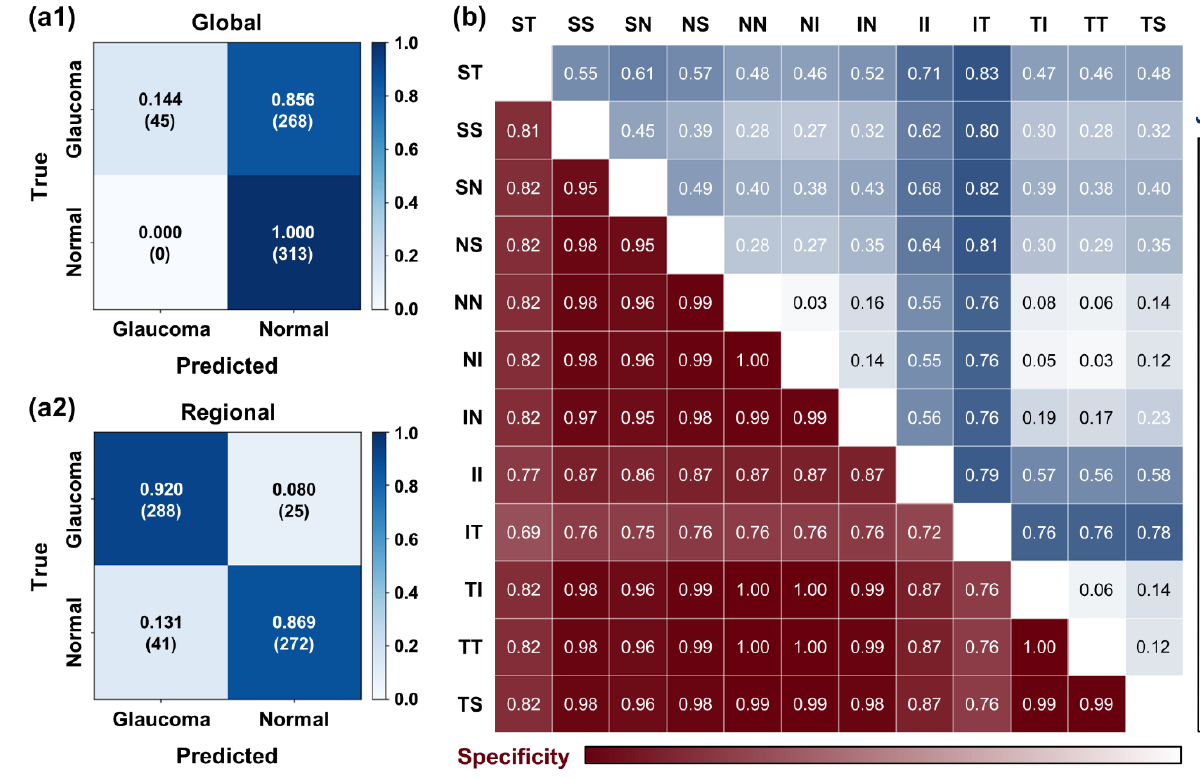
Figure 6. Screening performance comparison. The confusion matrix of glaucoma screening is based on the thickness level of ( a1 ) the global and ( a2 ) superior and inferior regions among the 12 regions. Numbers in angle bracket indicates the cases. ( b ) The sensitivity and specificity of screening results using two subsections for all possible combinations are represented as a colormap.